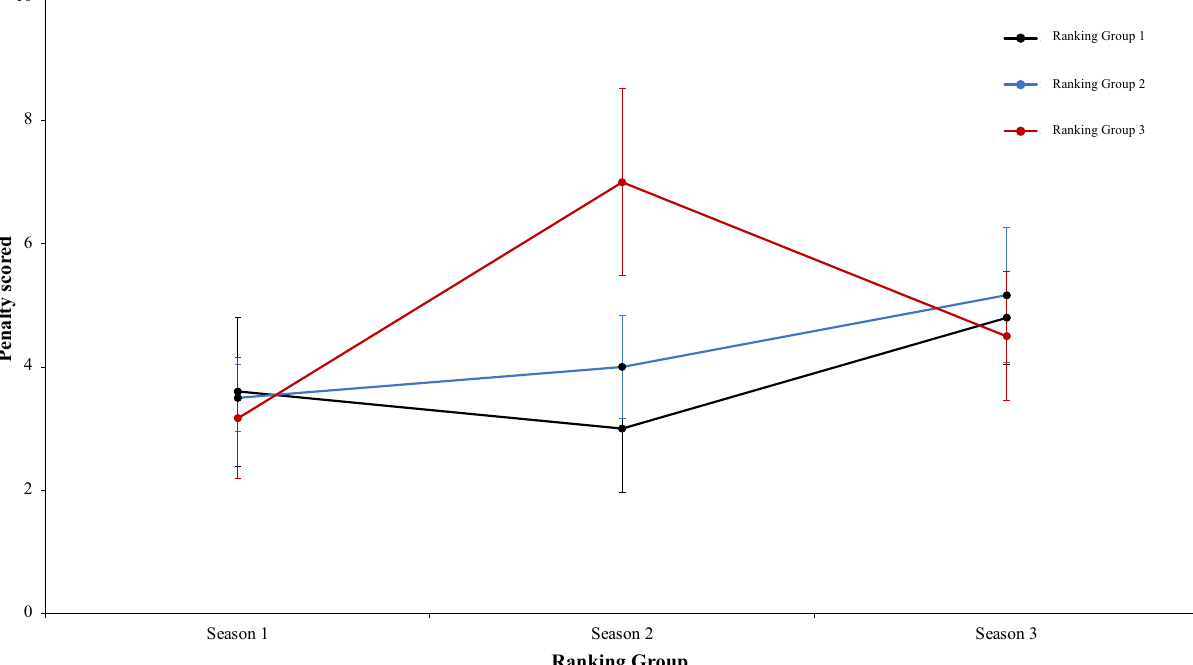
Figure 23. Technical performance. Mean penalty scored (± SE) as a funtion of Ranking and Season